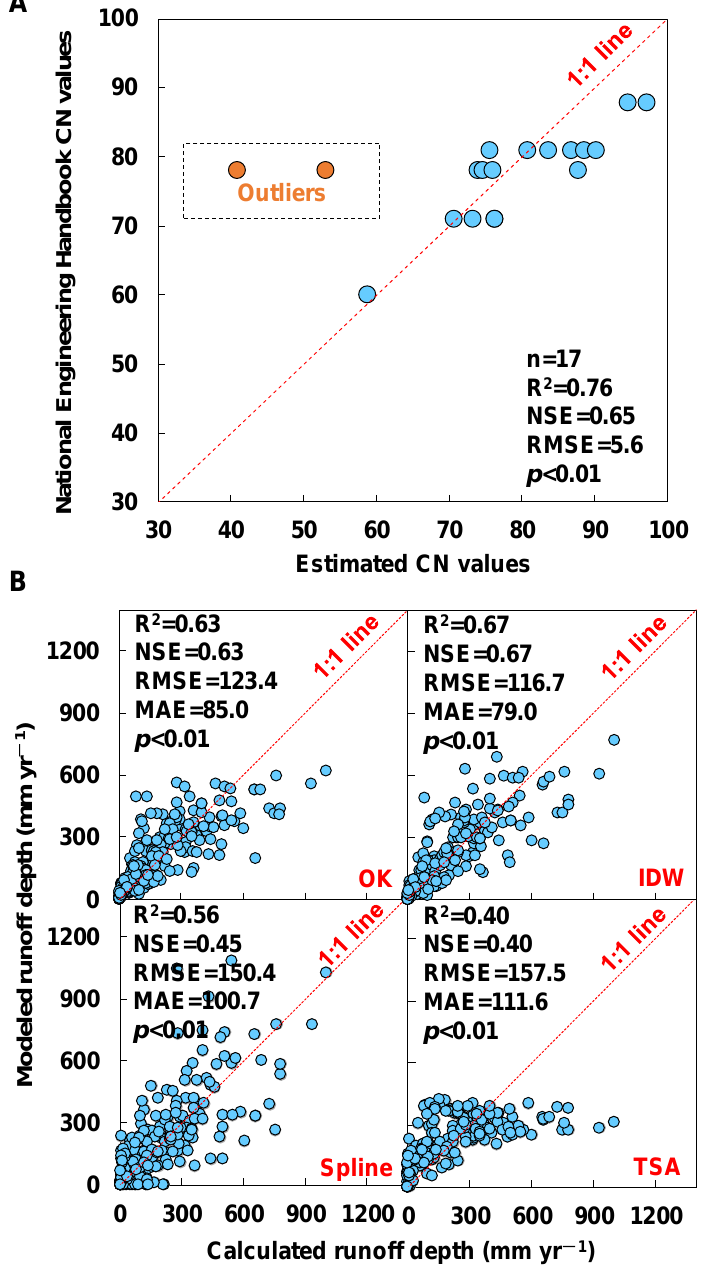
Calculated runoff depth (mm yr － 1 ) Figure 2. ( A ) Comparisons of estimated CN values from 19 studied catchments in China (orange dots denote CN values estimated from monthly rainfall-runoff data that were excluded due to their outlier status) and default CN values in the National Engineering Handbook, and ( B ) comparisons among four spatial interpolation methods (i.e., inverse distance weighting (IDW), ordinary kriging (OK), spline and trend surface analysis (TSA)) for predicting annual cropland runoff depths. n = 209.